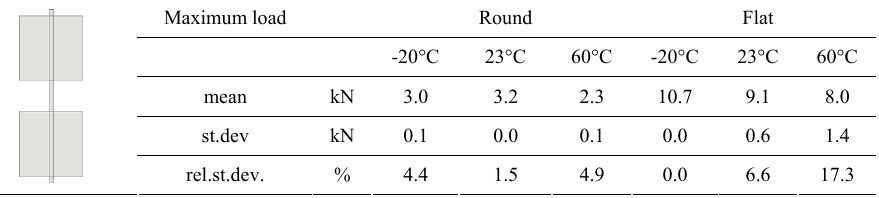
Table 4: Numerical results of the pull-out tests.